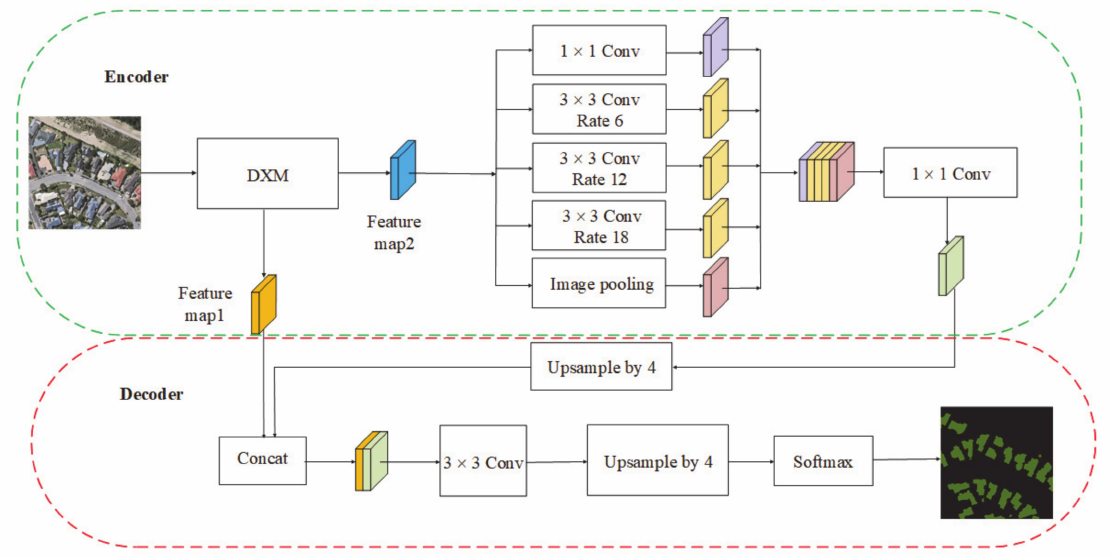
Figure 2. The basic structure of DR-Net which is modified from deeplabv3+Net. Compared with DeepLabV3+Net, the modified xception is replaced by the Dense xception module((DXM)) in DR-Net. DCCN and ResNet are introduced into the DXM which promotes the fusion of deep and shallow features In the Figure 3, structure of DXM is shown. conv represents the convolution operation; Filter() represents the convolution kernel, the numbers in parentheses represent the number of convolution kernels, the width and height of the convolution kernel; depthseparable_BN_Conv represents the depth separable convolution and batch normalization processing; stride represents the moving stride of the convolution kernel; RL represents the relu activation function, and [||] represents the splicing operation of feature maps in the channel dimension. In the entry flow, we adopt densely connected layers, which reduce the number of parameters and contribute to extract abstract features in shallow layers. We believe that, in deeper layers, abstract feature and detail features should be focused on at the same time. This is because in the deeper layers, the size of feature map is smaller, which could consume less memory of the computer. Thus, in middle flow, we adopted densely connected layers and modified residual layers. We connect feature maps in channel dimension instead of adding them together directly. In exit flow, similarly, modify as the entry flow is carried